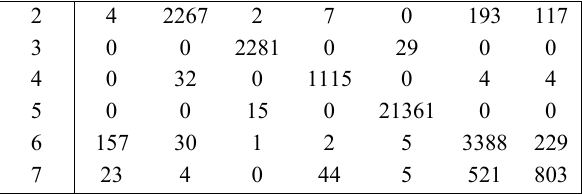
Table 5.1 Error matrix (pixel count) 2018 year